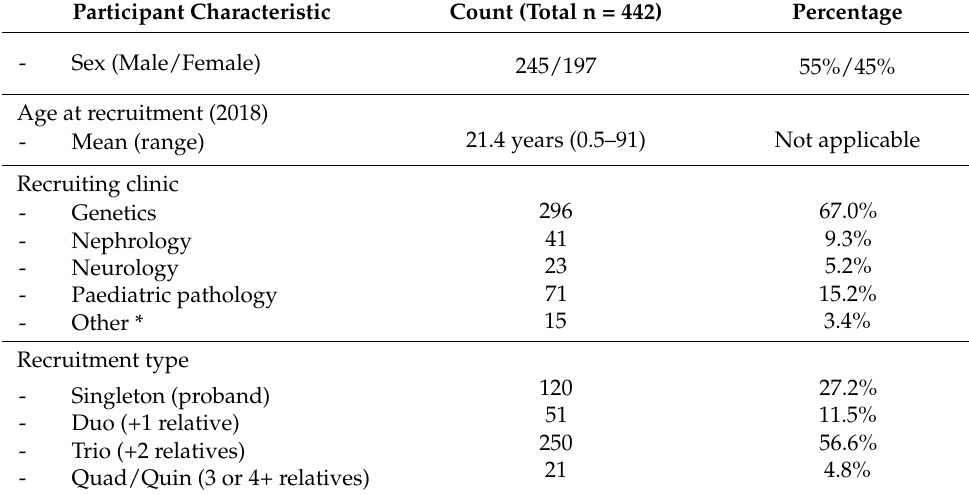
Table 1. Characteristics of probands.